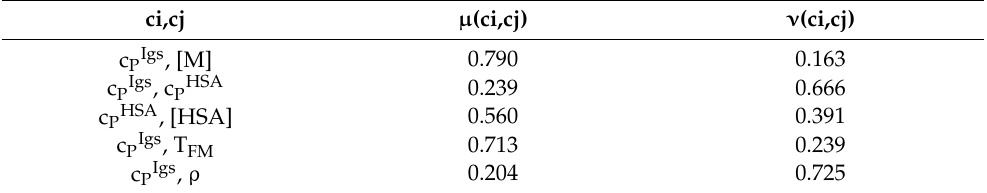
Table 3. Degrees of similarities µ (ci,cj) and differentiation ν (ci,cj) determined for the pairs of criteria ci and cj by means of ICA analyses on a dataset generated for secretory MM cases. The interrelations between the following criteria are presented: excess heat capacity of the immunoglobulins and albumin assigned transitions, c PIgs and c PHSA , respectively, concentration of albumin ([HSA]) and M-proteins ([M]), weighted average center of the thermogram, T FM , and similarity metric, ρ . ci,cj µ (ci,cj) ν (ci,cj) c PIgs , [M]